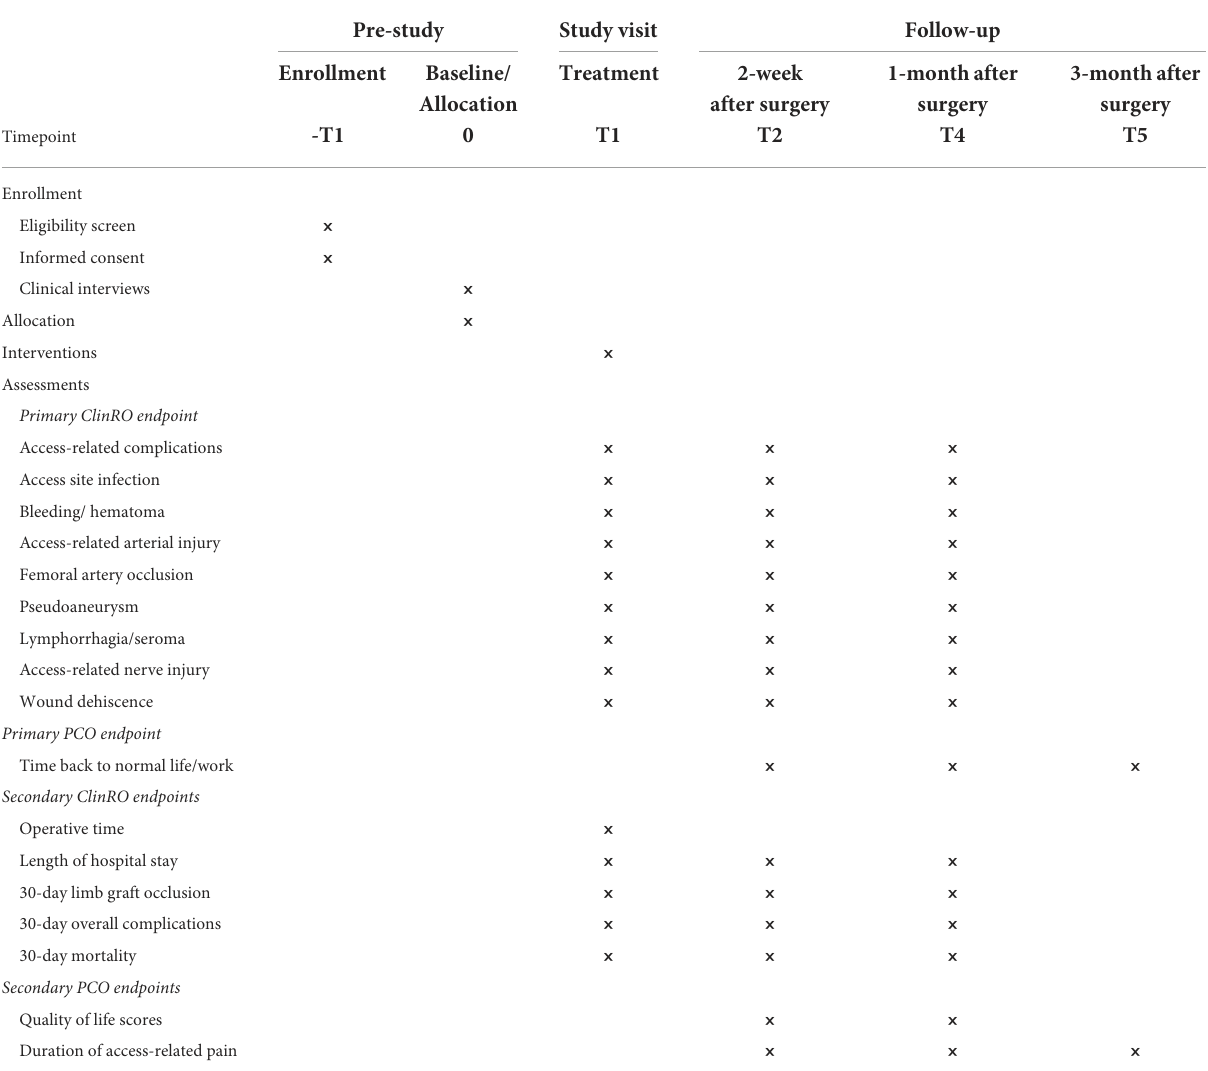
TABLE 1 SPIRIT schedule for the SWEET randomized controlled trial.